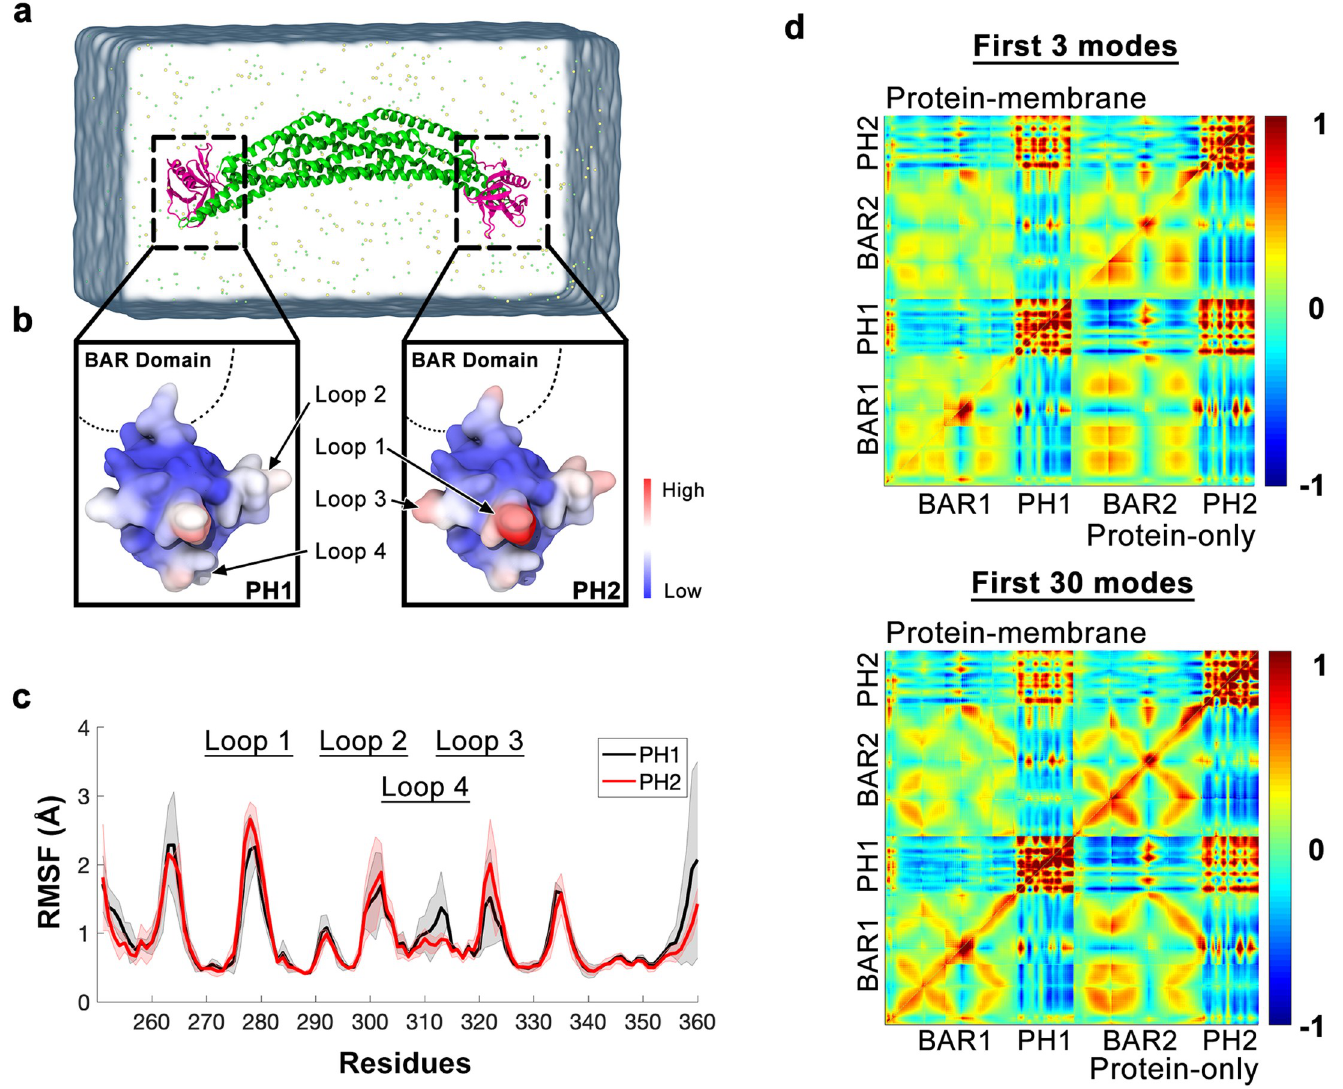
Fig 5. The asymmetric insertion of the ACAP1 BAR-PH dimer occurs during initial membrane recruitment. (a) Simulation set-up of one ACAP1 BAR-PH dimer in solvent with ions. The BAR domain is coloured in green while the PH domain is coloured in magenta. Ionic particles are represented in yellow and light green bubbles. (b) Projection of residue B-factors onto the molecular surface of the PH domains. Magnitudes were represented from low to high with the colour blue to red. Important contacting loops were marked with arrows. (c) RMSF profile of the two PH domains of ACAP1 BAR-PH dimer were coloured in black and red. Errors (shown in shadows) were calculated from three individual simulations, each using a 200-ns trajectory. (d) The correlated fluctuations of the C α atoms in the ACAP1 BAR-PH dimer by integrating the first 3 or 30 principle components calculated from MD trajectories.